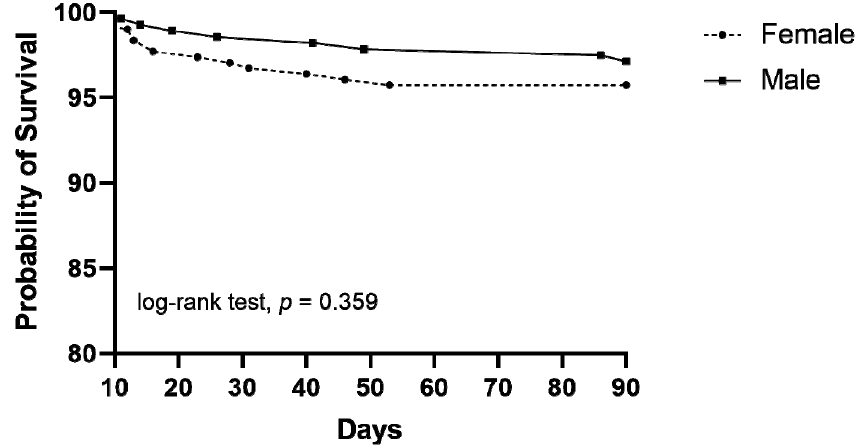
Figure 1. Kaplan–Meier curves of the patients according to sex (log-rank test, p = 0.359) . Table 4. Univariate and multivariate logistic regression analysis addressing the risk factors for in-hospital mortality.